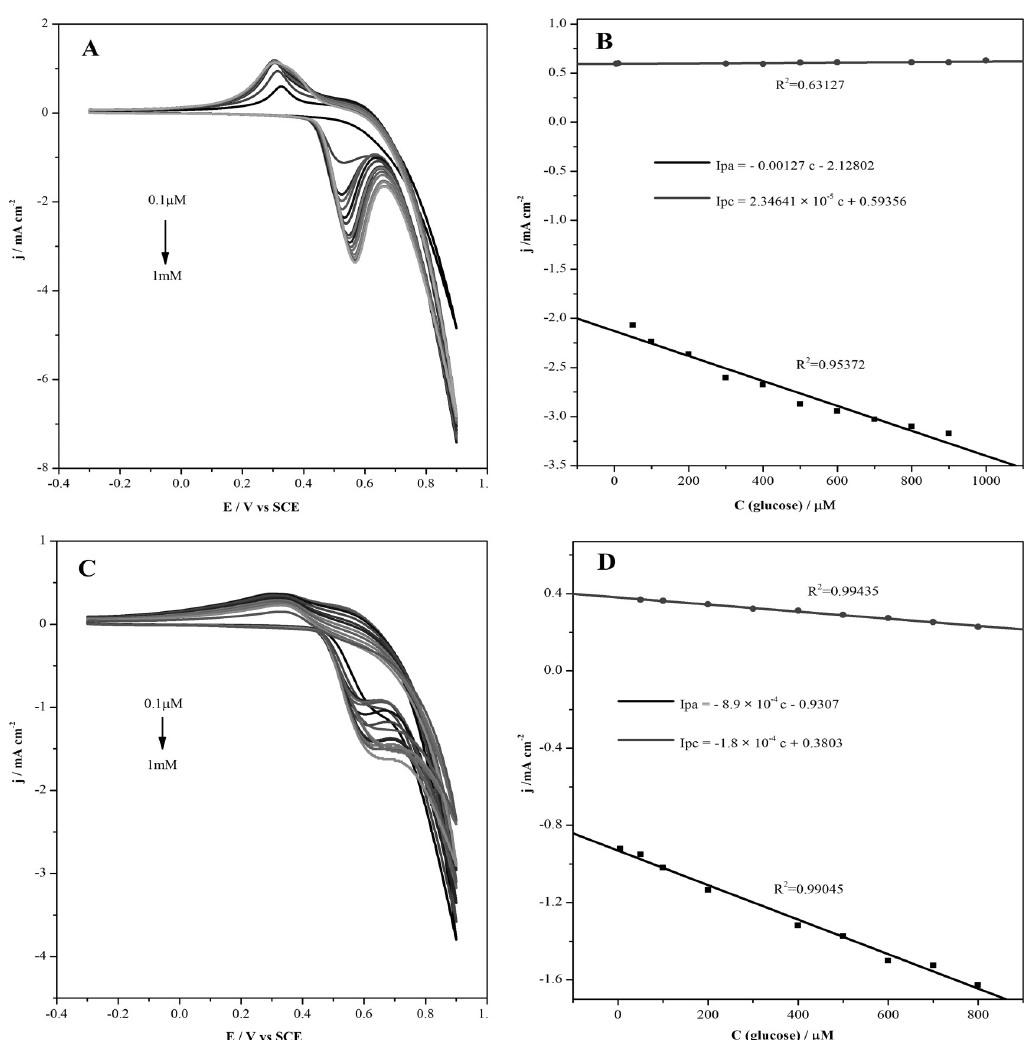
Fig 4. Electrocatalytic oxidation of Glucose on Cu@Ni CSNPs/Nafion/GCE and Cu@Ni CSNPs/N-GQDs/Nafion/GCE. CVs of modified Cu@Ni CSNPs/Nafion/GCE electrode at different glucose concentrations ( A ) and plot of peak current versus the different glucose concentrations ( B ); CVs of modified Cu@Ni CSNPs/N-GQDs/Nafion/GCE electrode at different glucose concentrations ( C ) and plot of peak current versus the different glucose concentrations ( D ).